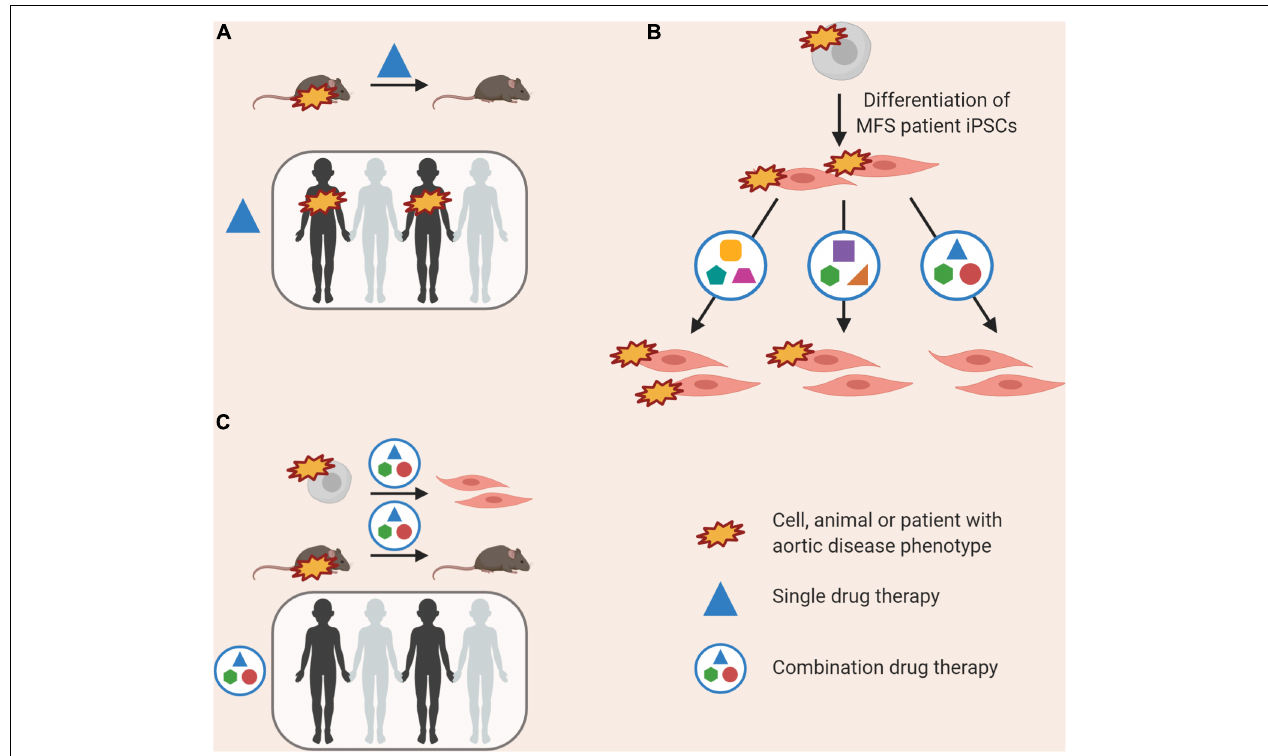
FIGURE 4 | Currently, successful use of a drug in animal models is the prerequisite for use in clinical trials (A) ; this may lead to an amelioration in disease phenotype in some individuals, but not all. “Clinical-trials-in-a-dish” can be performed, where the effects of a combination of drugs at low doses is tested on patient-derived VSMCs, allowing us to target multiple de-regulated pathways (B) . This combination therapy could then be validated in rodent models prior to use in clinical trials, and may have an effect in more patients (C)